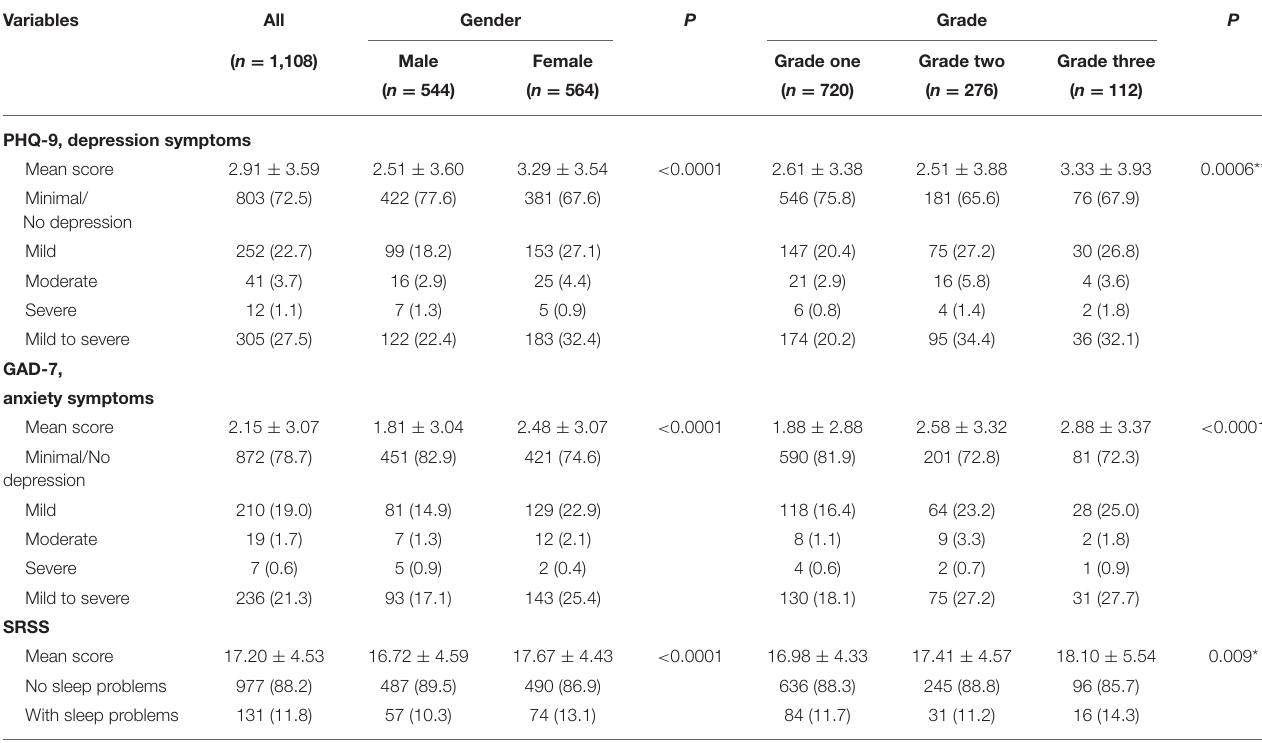
TABLE 2 | The rate of different psychological symptoms in high school students assessed by PHQ-9, GAD-7, and SRSS. Variables